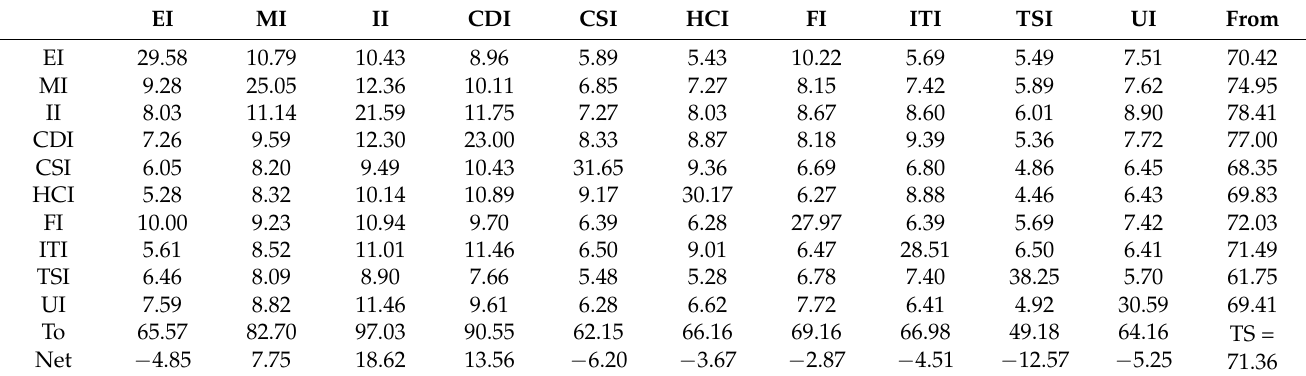
Table 4. Average of the rolling window financial shock transmission structure